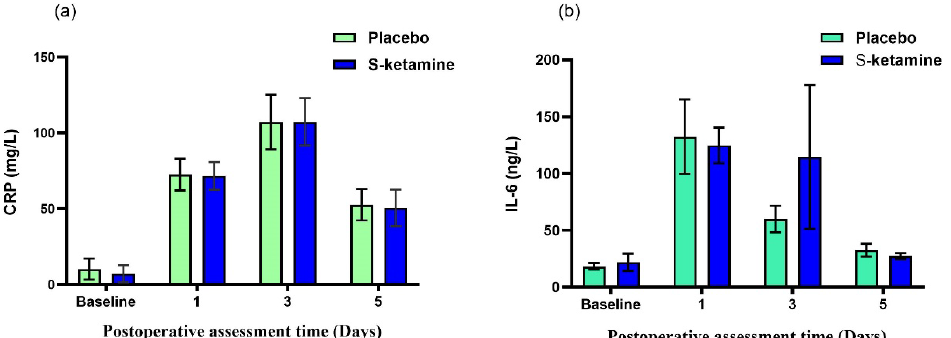
Figure 3. The change in CRP and IL-6 over time after surgery. ( a ) The values decreased over time (time effect F = 169.501, p < 0.001), but no significant differences between groups were seen (group effect F = 0.058, p = 0.811; group-by-time interaction F = 0.048, p = 0.986). ( b ) The values decreased over time (time effect F = 8.230, p < 0.001), but no significant differences between groups were seen (group effect F = 0.282, p = 0.597; group-by-time interaction F = 0.686, p = 0.561). CRP, C-reactive protein; IL-6, interleukin 6.